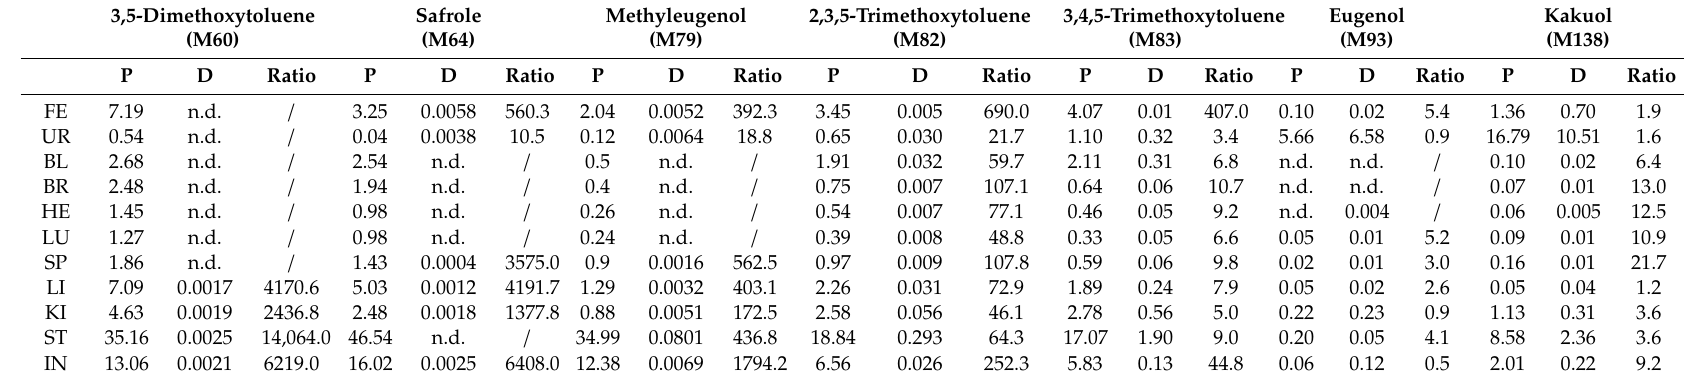
Table 4. Peak areas of main absorbed constituents and their ratio between di ff erent administration groups ( × 10 6